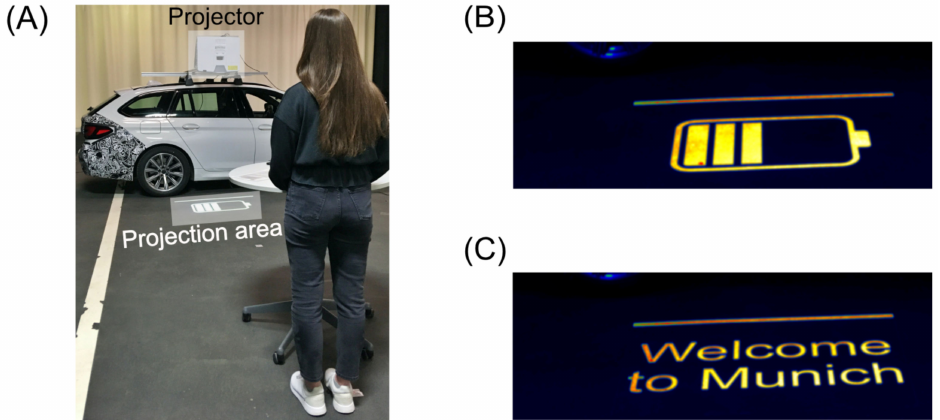
Figure 2. Extract of the study and examples of luminance measurements. ( A ) Participant at 3 m observation distance to the projection area in the DDS. The observed projection content consists of the battery symbol on the fine-grained asphalt. ( B ) Luminance measurement of the symbol-based projection in the PGS from a first-person viewing perspective of 3 m [34]. ( C ) Luminance measurement of the text-based projection in the PGS from a first-person viewing perspective of 3 m